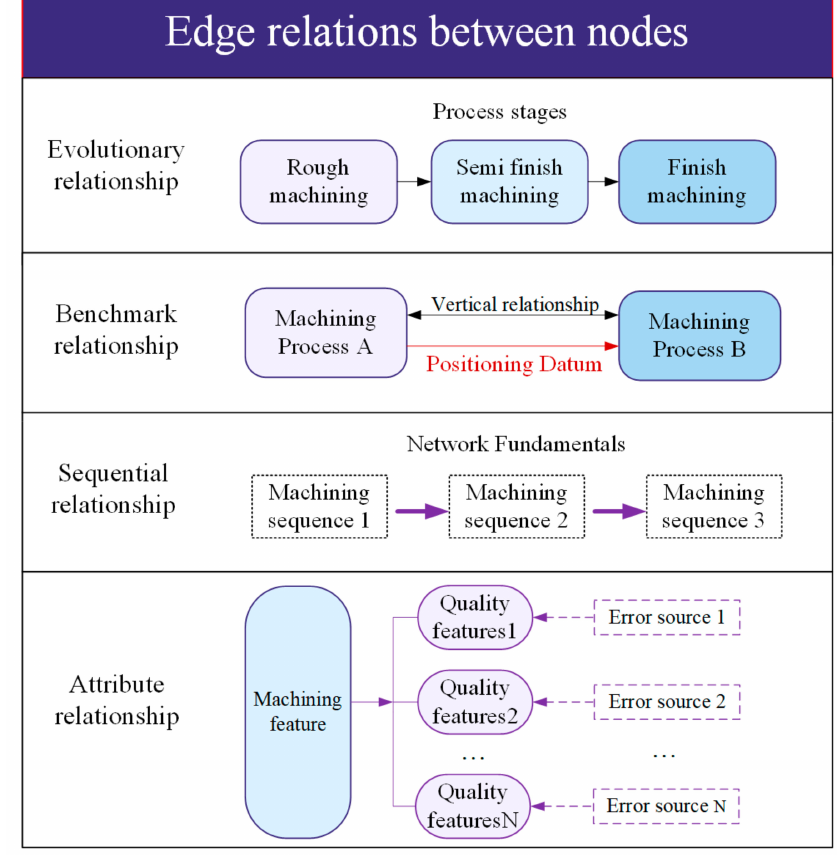
Figure 2. Edge relations between